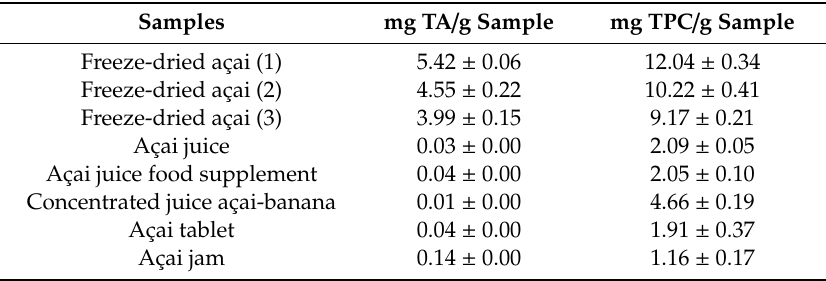
Table 4. Average ± RSD values of TA and TPC in real açai samples ( n = 3).